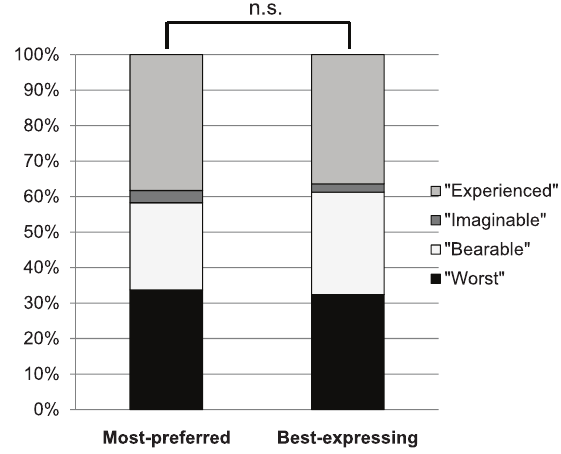
Figure 2. Comparison of percentages between the most- preferred and best-expressing descriptor. n.s., not